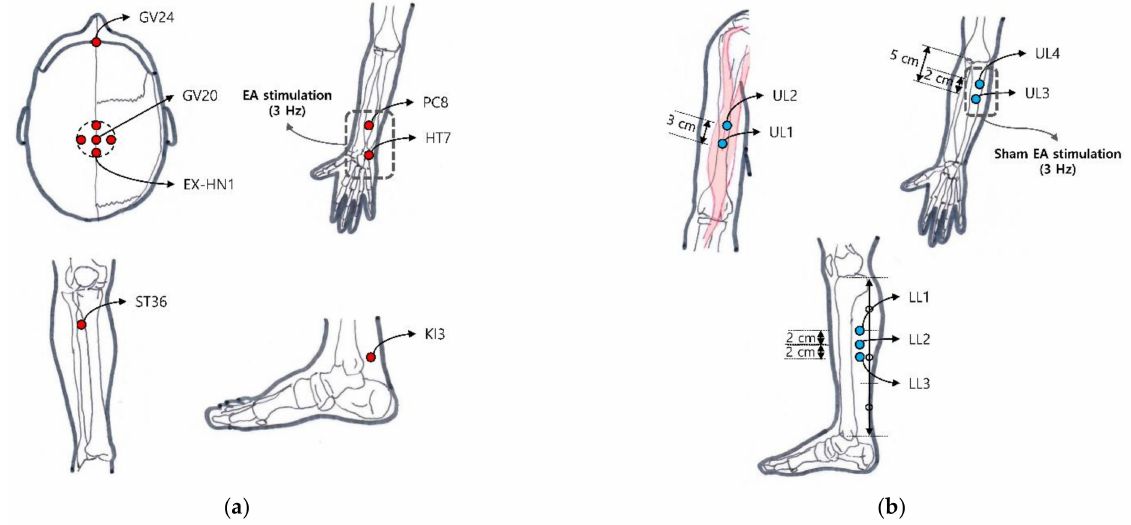
Figure 1. Locations of classical acupoint and non-classical acupoint: ( a ) GV24, GV20, EX-HN1, bilateral ST36, PC8, HT7, KI3 were selected as classical acupoints in the EA group; ( b ) On the other hand, four bilateral points located in upper limbs and three bilateral points located in lower limbs were selected for the sham electro-acupuncture group. Sham EA stimulation was applied with light and sound stimulation at a frequency of 3Hz without electric